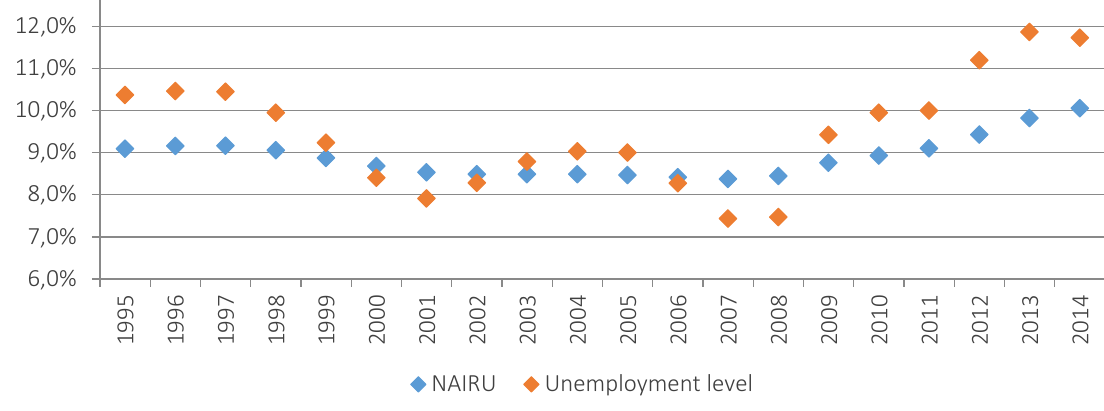
and the rate of unemployment that does not accelerate inflation (NAIRU)